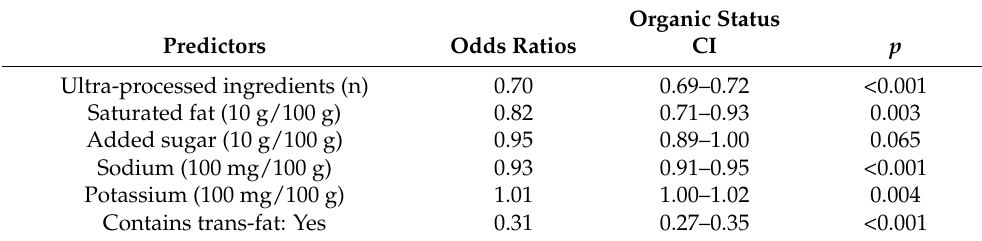
Table 5. Results from mixed logistic regression model of 3661 organic and 28,596 conventional products that had complete nutritional information for parameters included in this model. This model included the parameter “ultra-processed ingredients”.